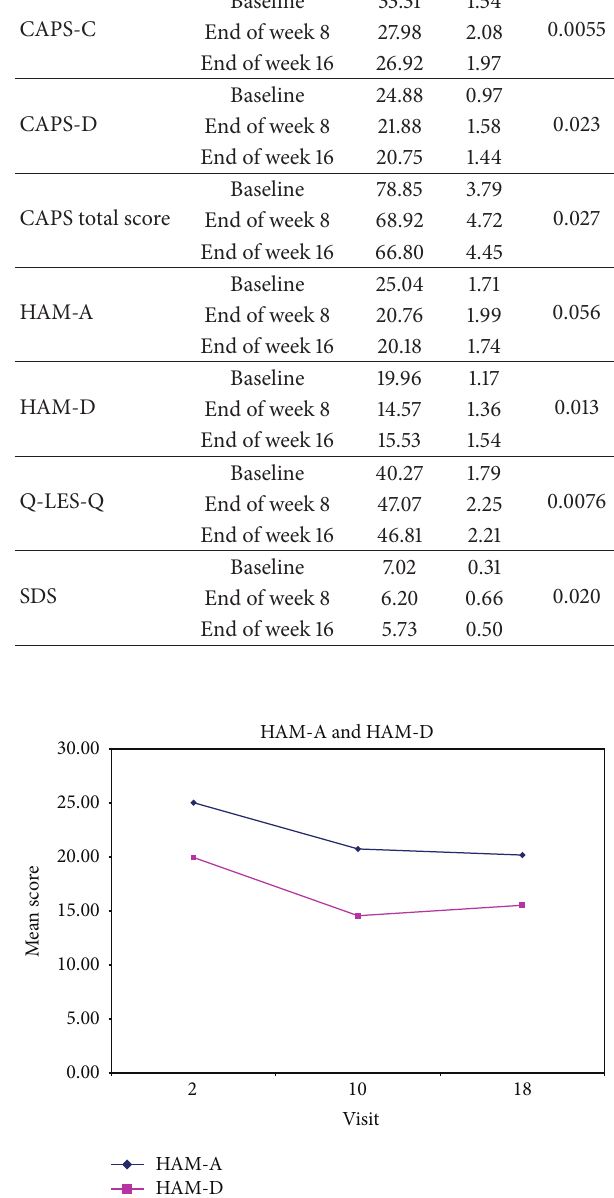
Figure 4: This figure illustrates changes in Hamilton Depression Scale and Hamilton Anxiety Scale scores over time.